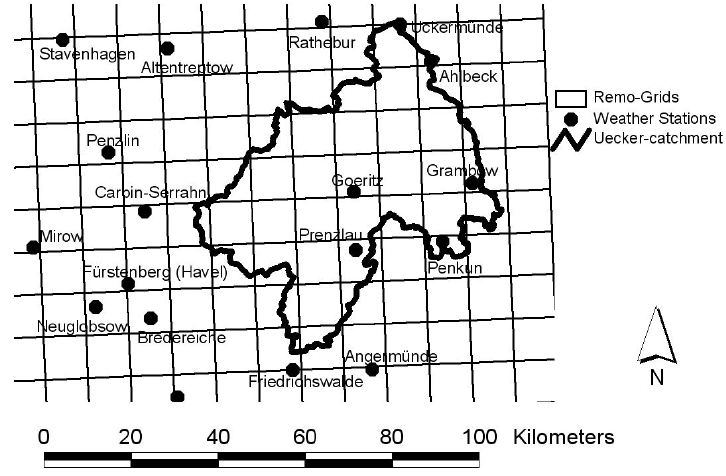
Fig. 2. Station network for STAR and WettReg as well as REMO-Grids for the Ucker catchment.